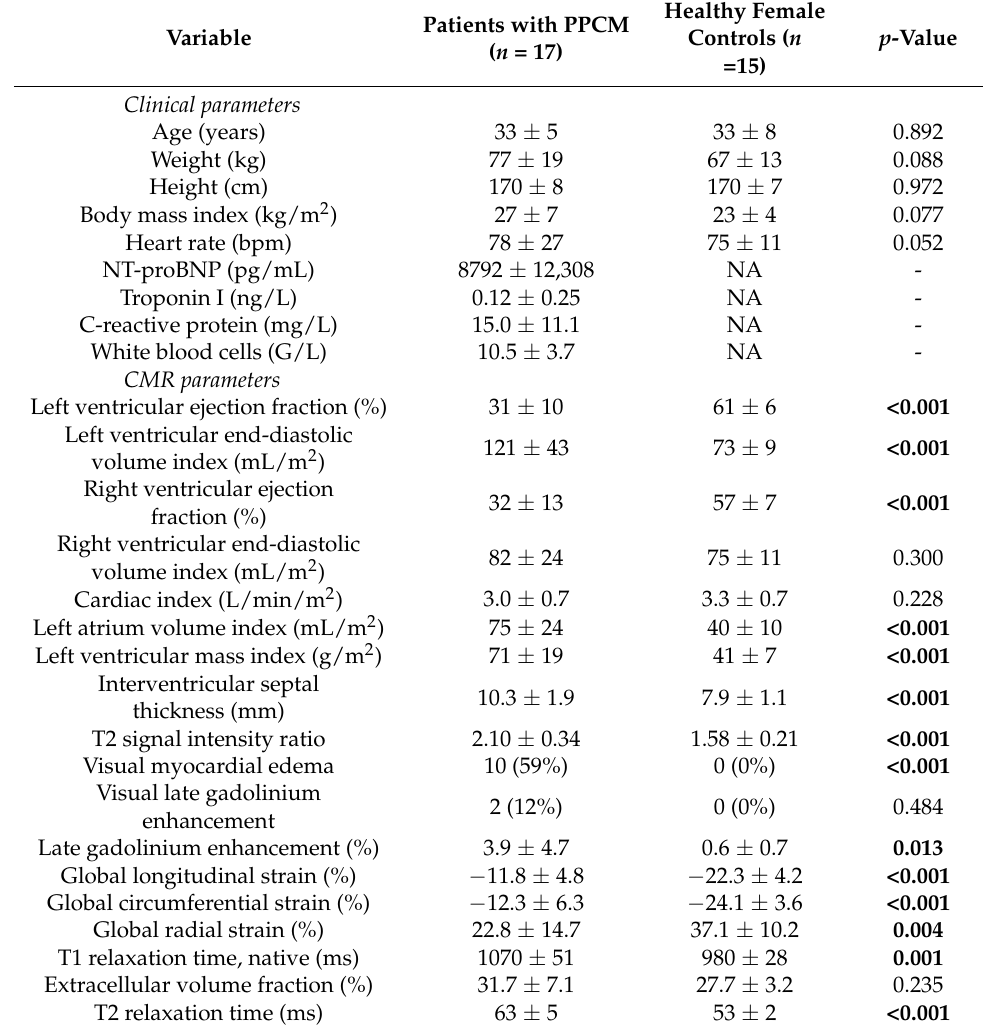
Table 1. Clinical and cardiac magnetic resonance imaging characteristics of patients with acute peripartum cardiomyopathy (PPCM) and healthy